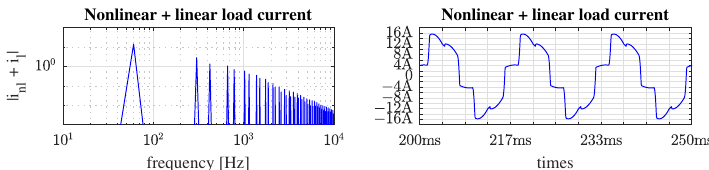
Figure 15. Nonlinear plus linear load current: FFT results and waveform.